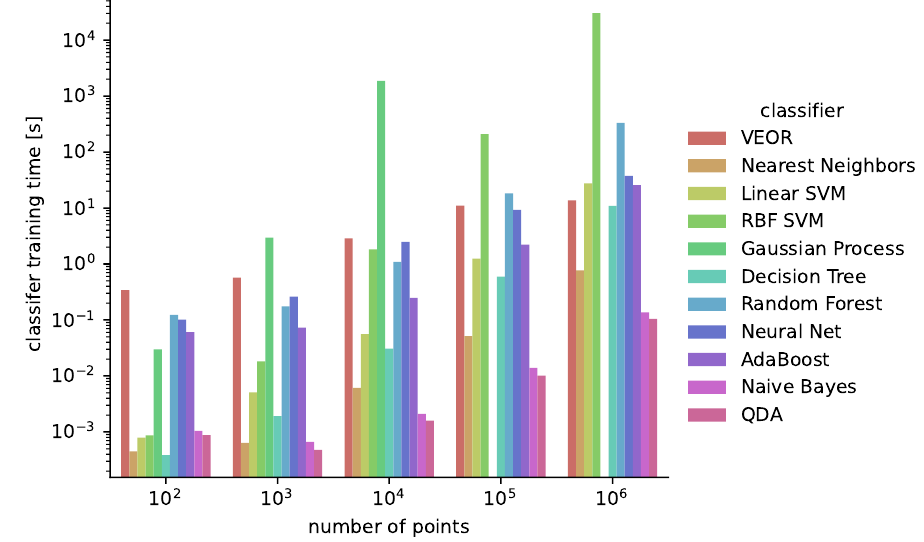
Figure 9. Comparison of single-core algorithm training processing times for selected classifiers.